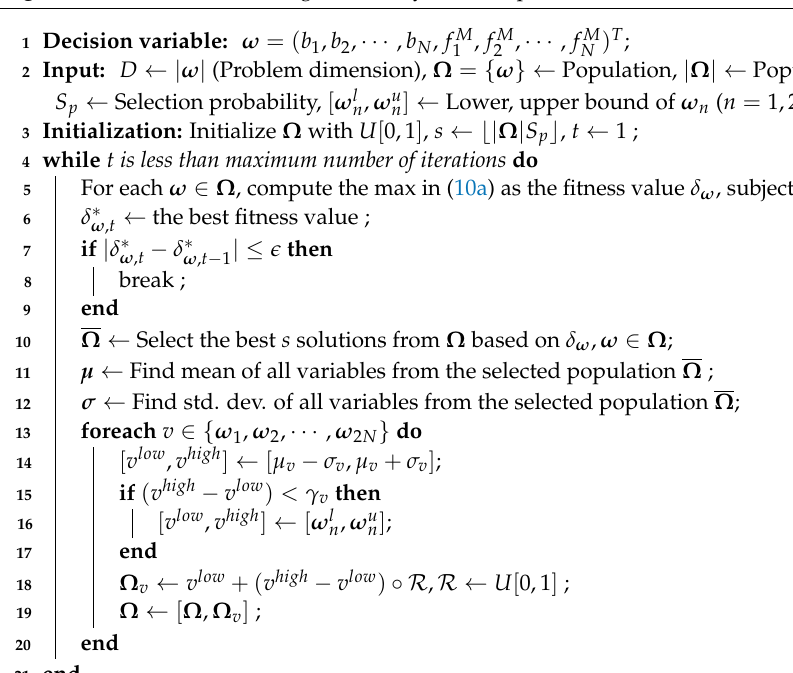
Algorithm 1: Partial Offloading with Relay and Adaptive Bandwidth Allocation (PORAB)